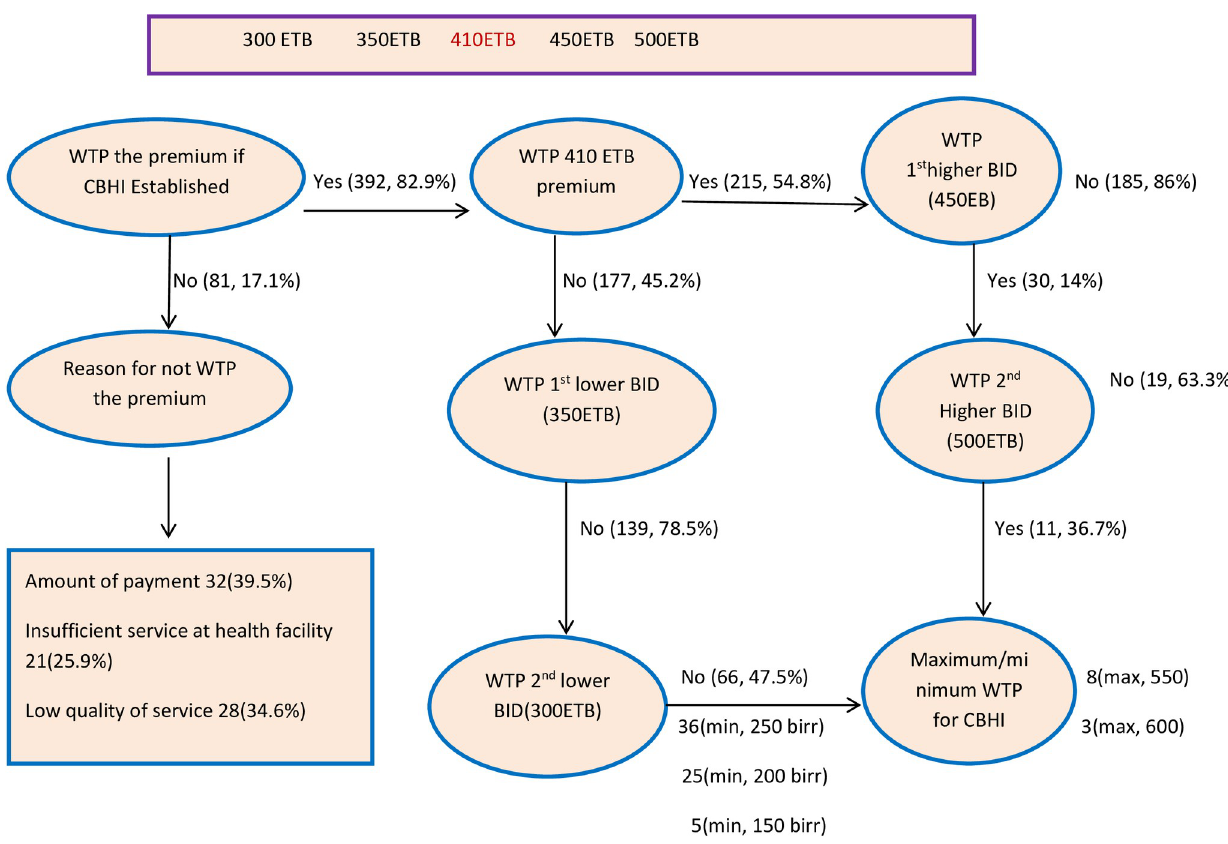
Fig 3. Participants’ willingness to pay for community based health insurance scheme, 2021.